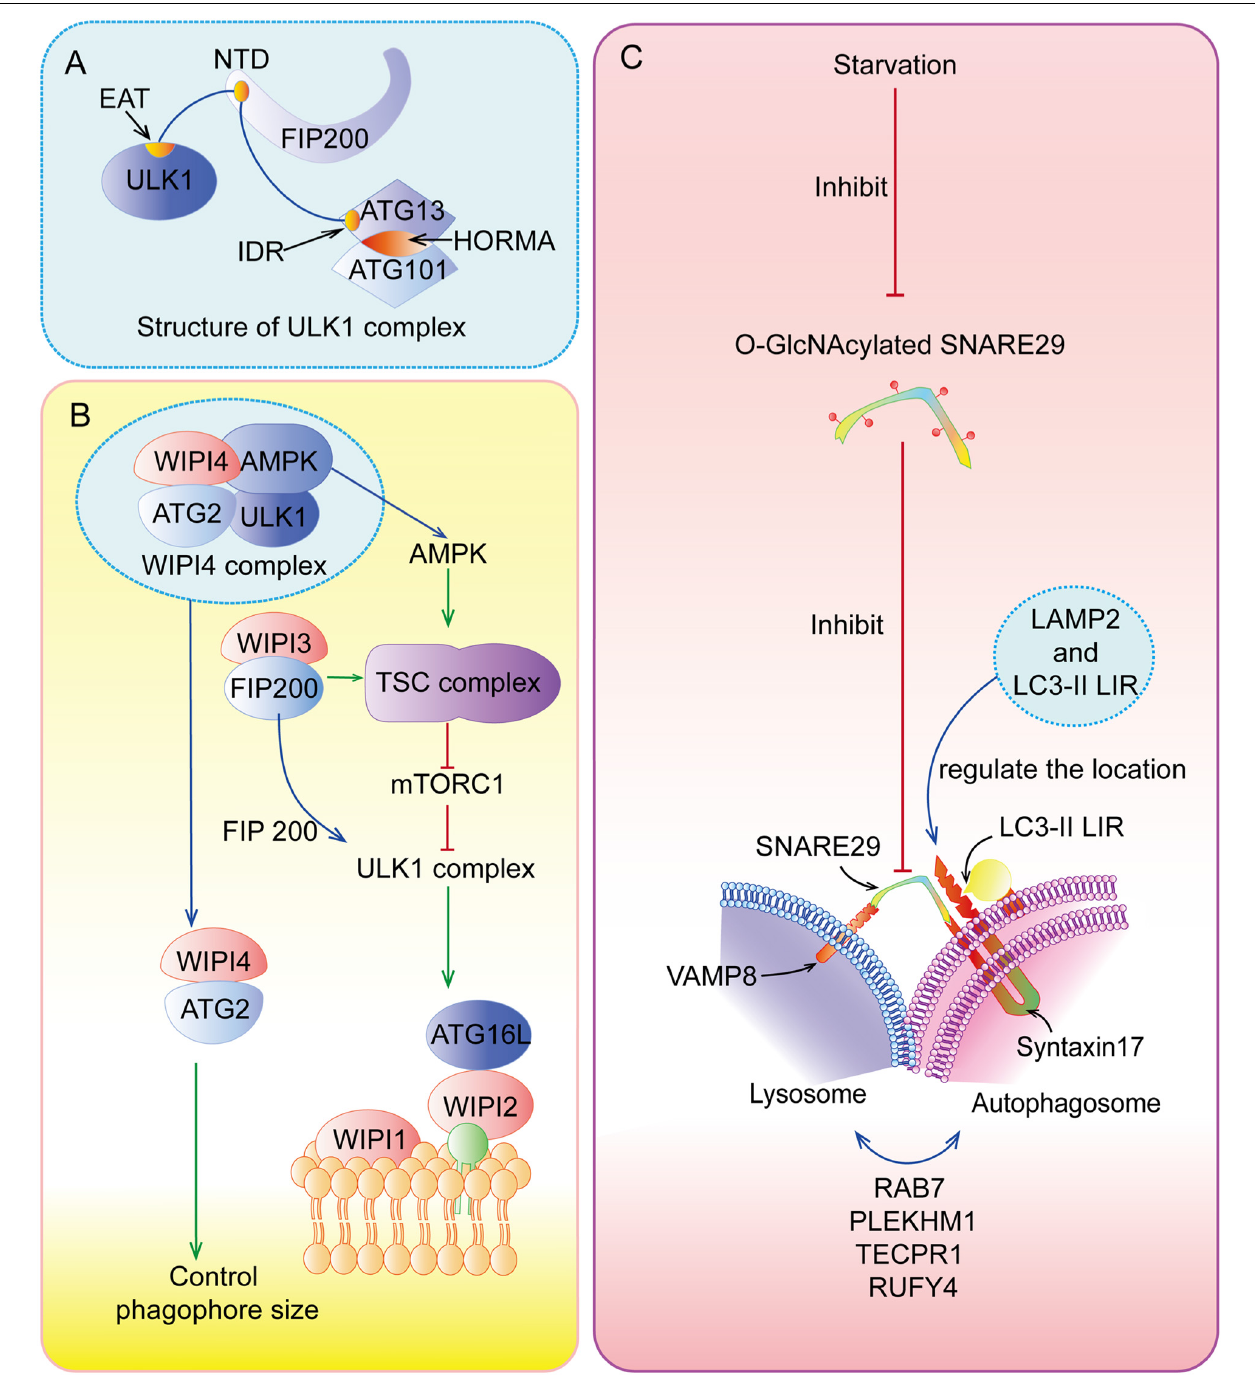
FIGURE 2 | Special parts of autophagy. (A) The structure of ULK1 complex. (B) The functions of WIPIs in autophagy. (C) The fusion between lysosome and